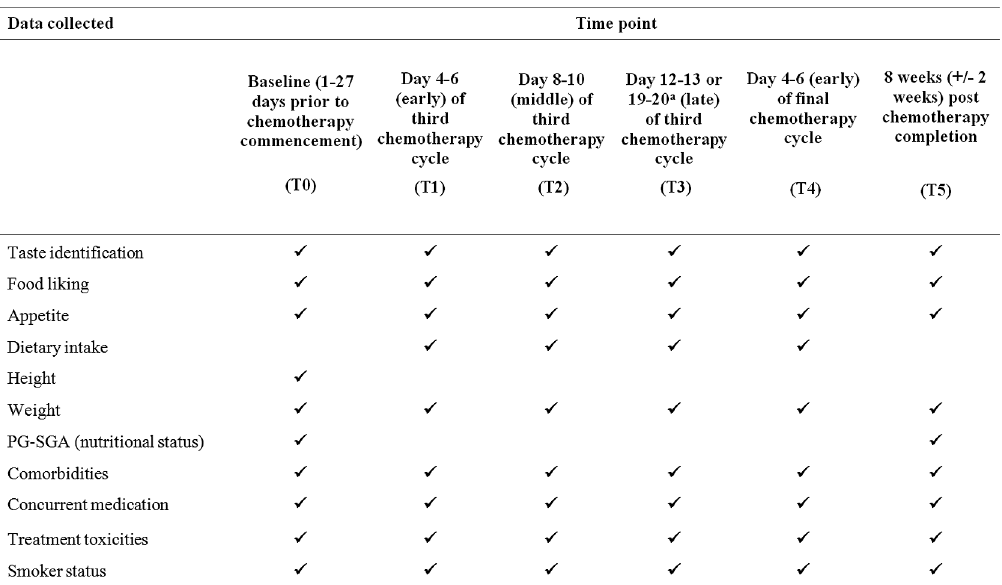
Figure 1. Summary of outcome data collected at each study time point. a Day 12–13 of the third chemotherapy cycle if receiving 14 day chemotherapy cycles. Cycle 3, Day 19–20 if receiving 21 day chemotherapy cycles.